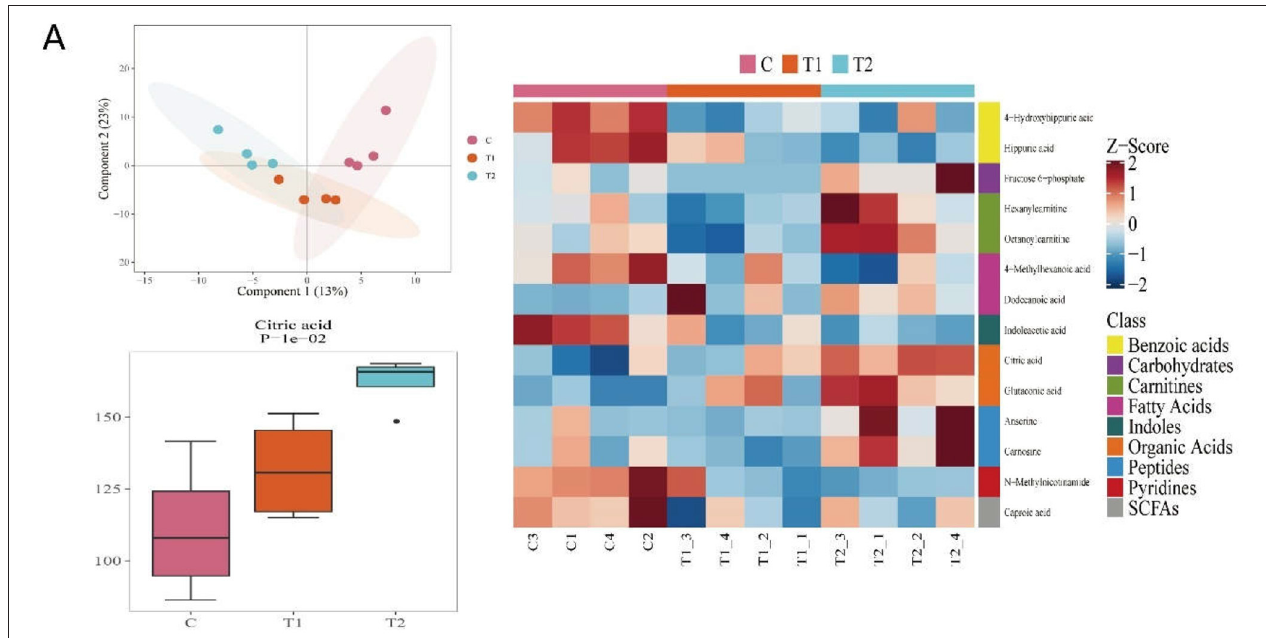
FIGURE 2 | The feed of Hermetia illucens larvae increased the content of metabolite citric acid (CA) in piglet serum samples. The results of (A) serum metabolomics test ( n = 4, means ±